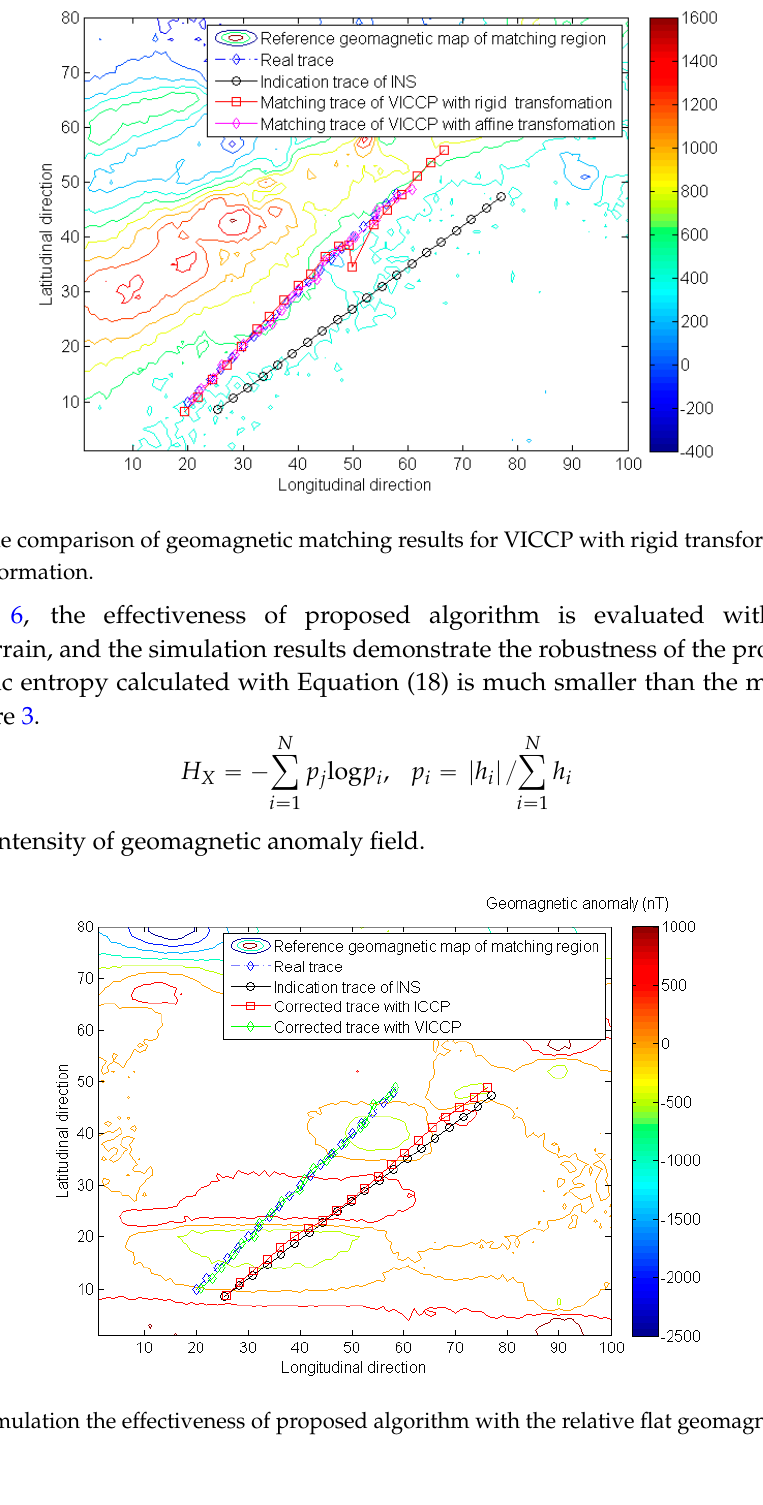
Figure 6. Simulation the effectiveness of proposed algorithm with the relative flat geomagnetic terrain.